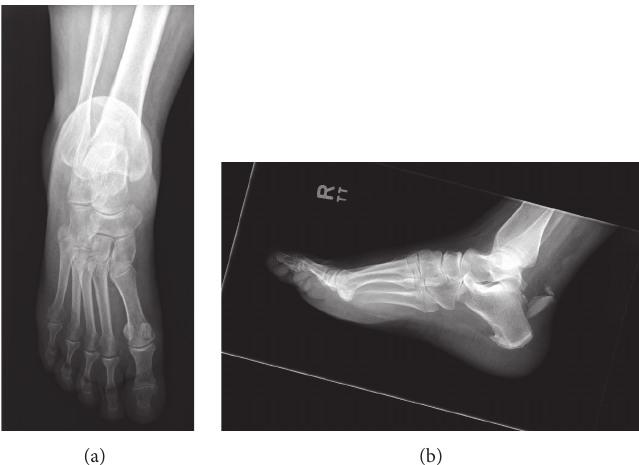
Figure 1: Anteroposterior (a) and lateral (b) radiographs demonstrating displaced fragmented calcaneal tuberosity avulsion following injury.